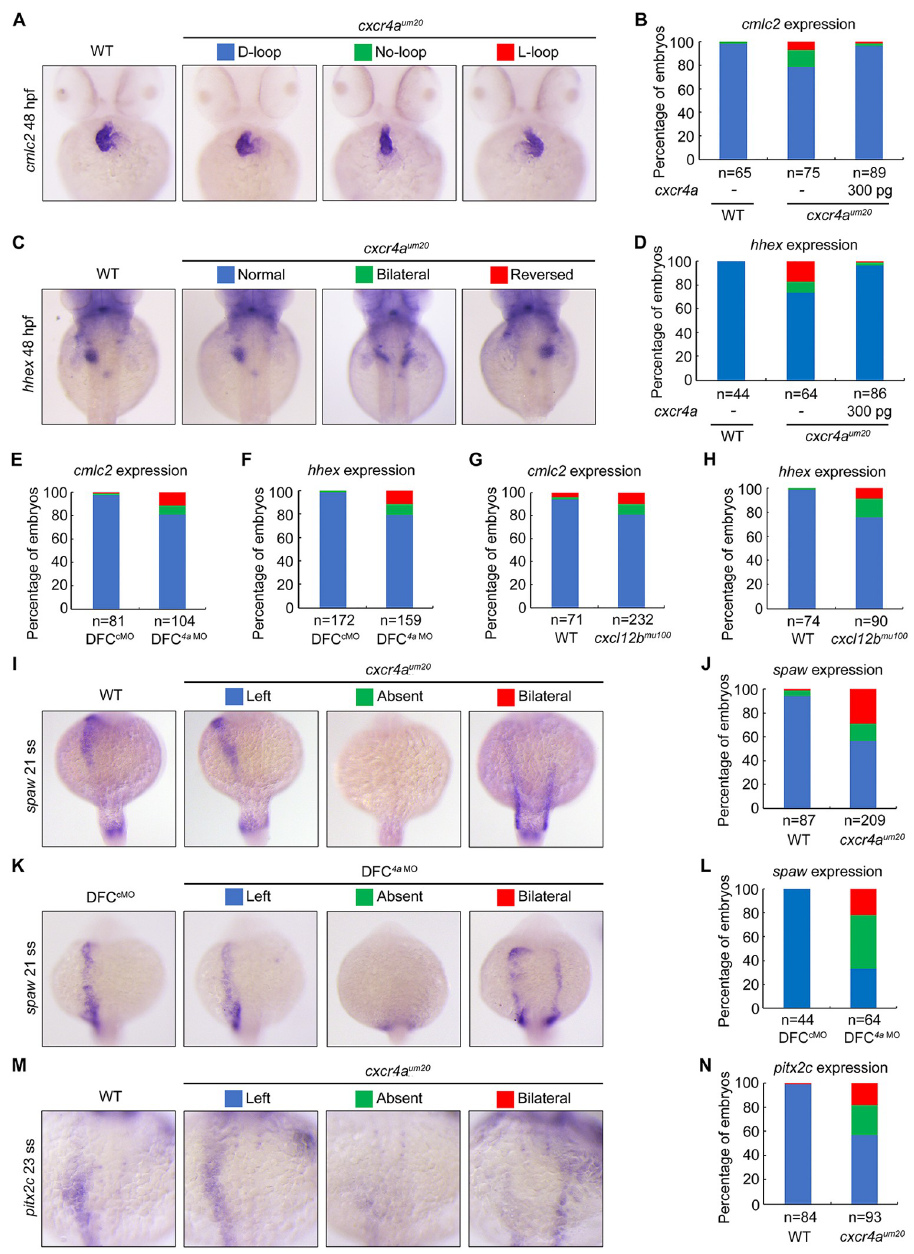
Fig 1. Cxcl12b–Cxcr4a signaling axis is essential for L–R asymmetric development. (A–D) WT embryos and cxcr4a um20 mutants injected with or without 300 pg cxcr4a mRNA at the 256-cell stage were examined for cardiac looping and liver laterality at 48 hpf by WISH against cmlc2 (A) and hhex (C). Embryos with different phenotypes are shown in ventral (A) or dorsal view (C), and the ratios are shown in (B) and (D). Underlying data can be found in S1 Data. (E–H) Embryo ratios with different expression patterns of cmlc2 and hhex at 48 hpf in WT embryos injected with 8 ng cxcr4a MO ( 4a MO) at the 256-cell stage (E and F) and cxcl12b mutants (G and H). Underlying data can be found in S1 Data. (I–N) cxcr4a deficiency alters Nodal gene expression pattern. Representative images of spaw and pitx2c expression in cxcr4a mutants (I and M) and morphants (K). All embryos are shown in dorsal views with anterior on the top. Ratios of embryos are shown in (J), (L), and (N). Underlying data can be found in S1 Data. cmlc2 , cardiac myosin light chain 2; DFC, dorsal forerunner cell; hhex , hematopoietically expressed homeobox; hpf, hours postfertilization; L–R, left–right; MO, morpholino; pitx2c , paired-like homeodomain 2c ; spaw , southpaw ; WISH, whole- mount in situ hybridization; WT,